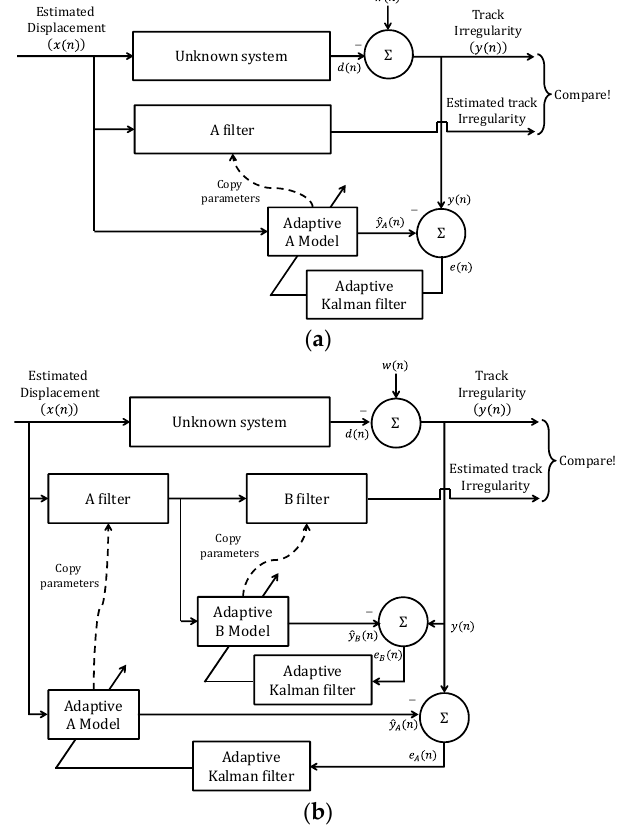
Figure 3. Adaptive filtering for system identification: ( a ) single model; ( b ) hybrid model.